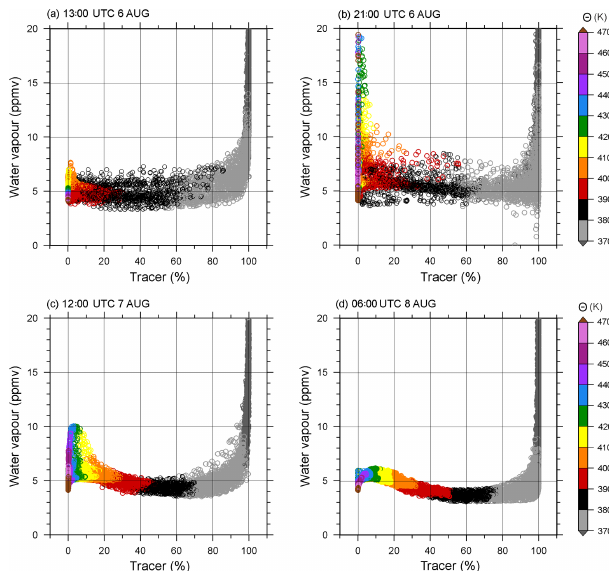
Figure 12. Mixing diagram using tropospheric tracer (%) and water vapour (ppmv) across the hydration patch in the altitudes between 14 and 22kma.s.l. along the trajectory at (a) 13:00UTC on 6 Au- gust, (b) 21:00UTC on 6 August, (c) 12:00UTC on 7 August, and (d) 06:00UTC on 8 August 2017. The potential temperature (K) is shown with colour